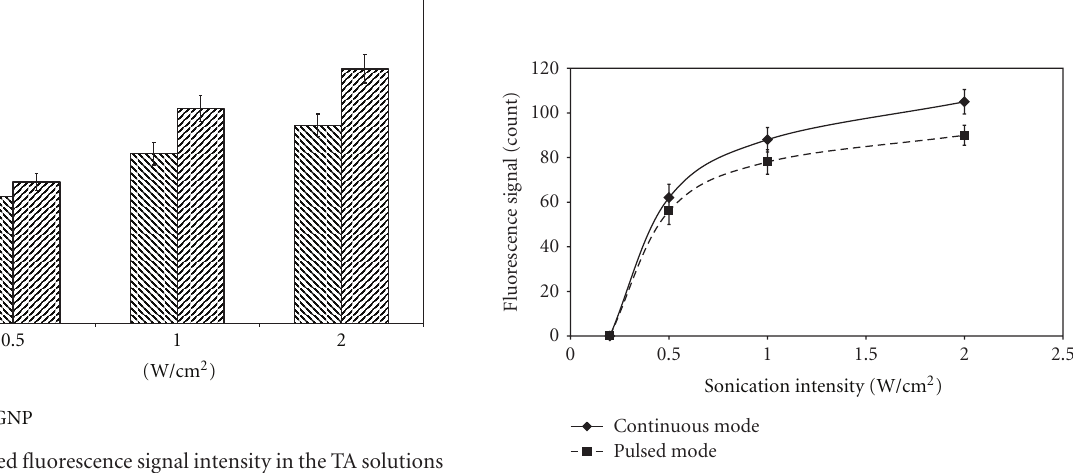
Figure 6: Recorded fluorescence signal from the TA solution containing gold nanoparticles in the field of 1MHz ultrasound waves at intensities of 0.5, 1, and 2W/cm 2 in continuous and pulsed (in duty cycle of 50%) modes, excitation wavelength = 310 nm, and emission and excitation band width =